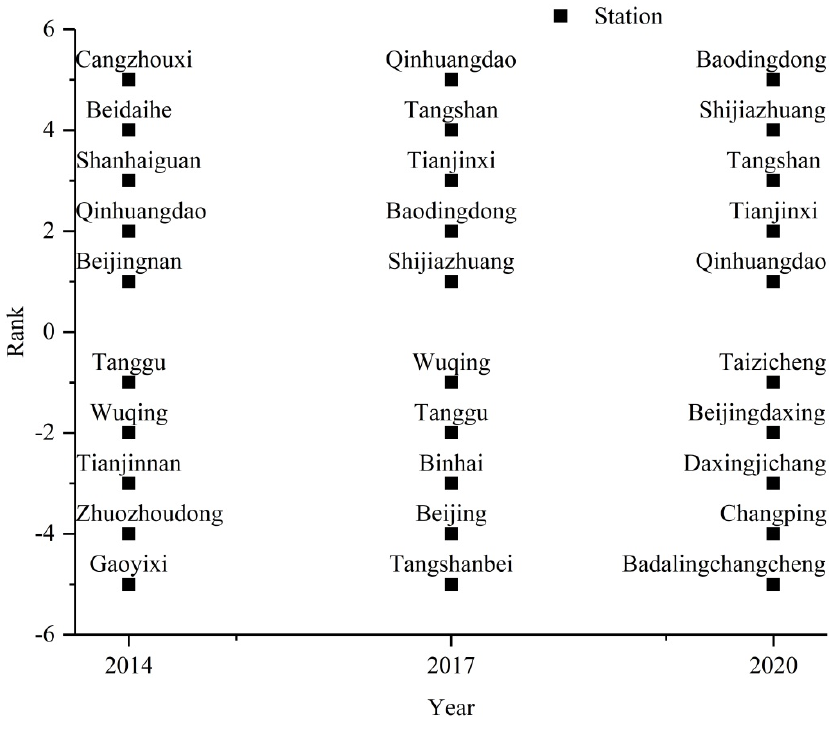
Figure 4. The ranking of the eigenvector centrality index for HSR stations in the Beijing-Tianjin-Hebei urban agglomeration. (Note: − 1 means the lowest ranking).